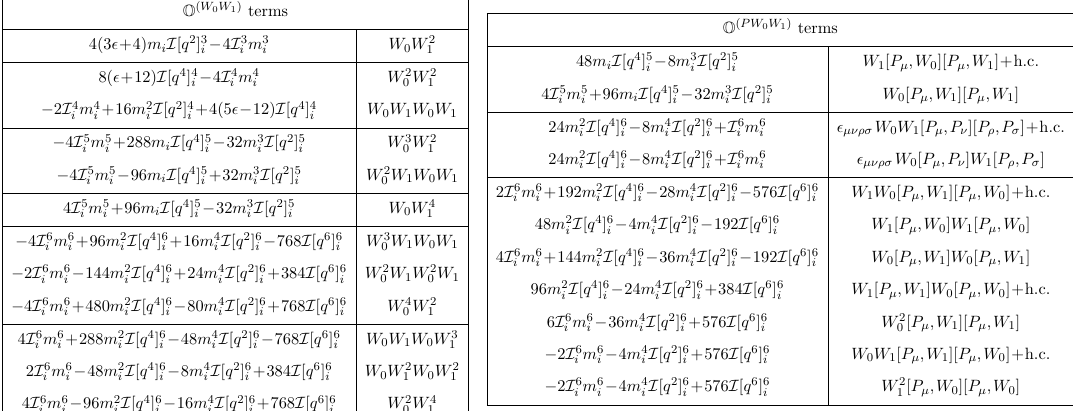
Table 7 . Operator structures in the degenerate fermionic UOLEA involving both the scalar cou- pling W 0 and the pseudoscalar coupling W 1